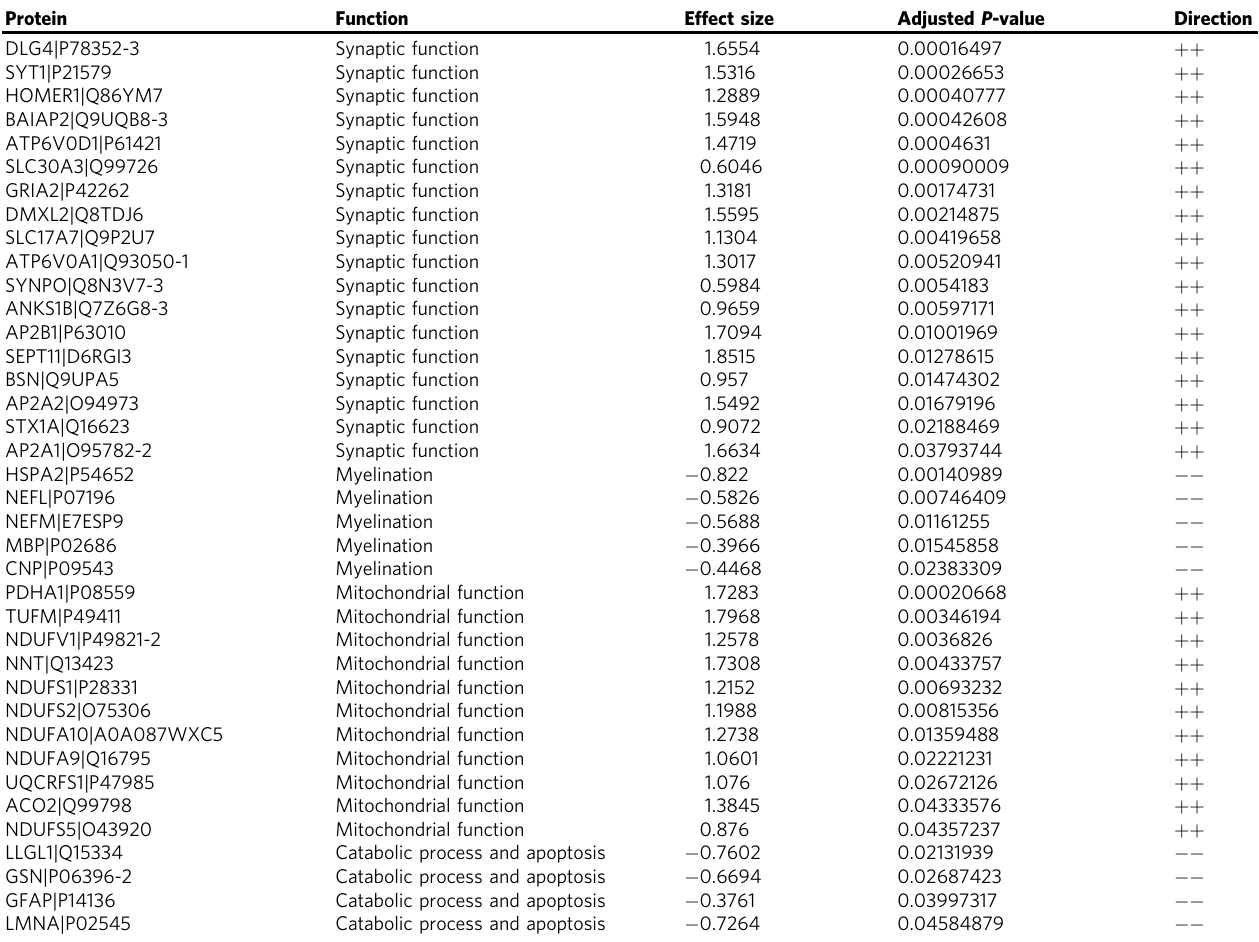
Table 5 Co-expression hub proteins associated with cognitive trajectory